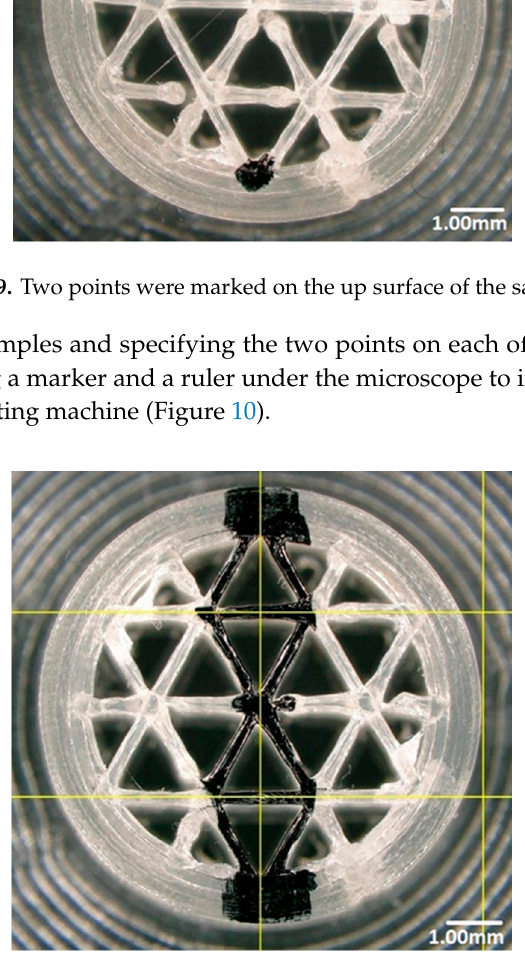
Figure 10. The marked points were connected together under the microscope.